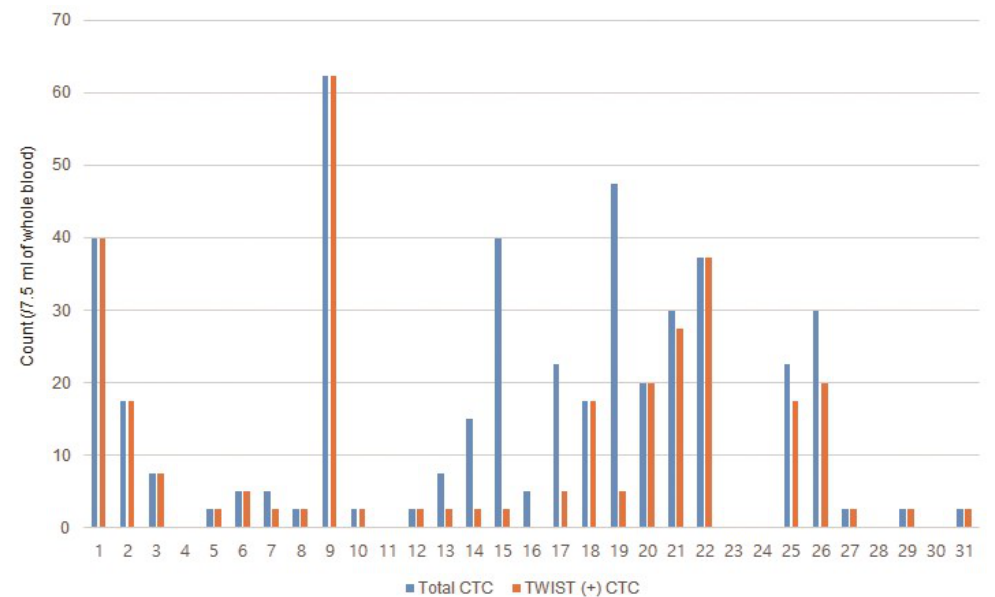
Figure 3. Circulating tumor cell (CTC) and TWIST (+) CTC counts in the 31 patients with metastatic gastric cancer. Table 2. Circulating tumor cell (CTC) and TWIST (+) CTC counts according to the clinicopathologic characteristics of 31 patients with metastatic gastric